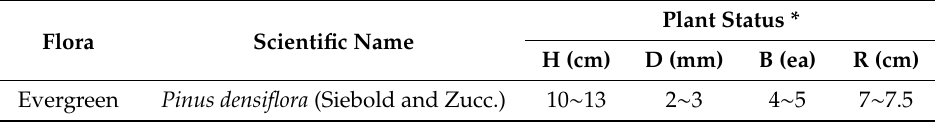
Table 1. Status of seedlings used in the